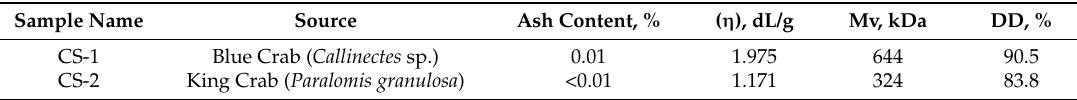
Table 1. Chitosan characterization.